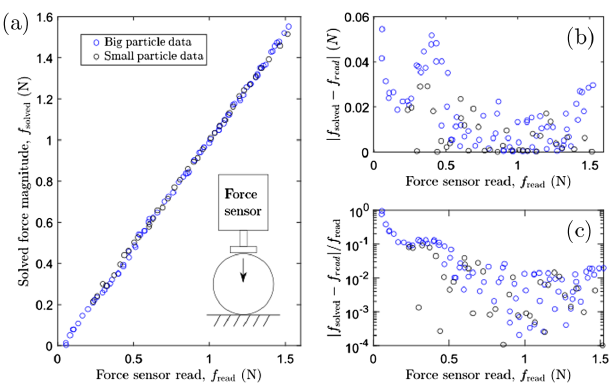
FIG. 10. (a) Solved contact force magnitude from the fitting algorithm compared to the read from a commercial force sensor in a diametric loading test on a single disk. (b) and (c) plot the absolute error and the relative error of the solved forces,